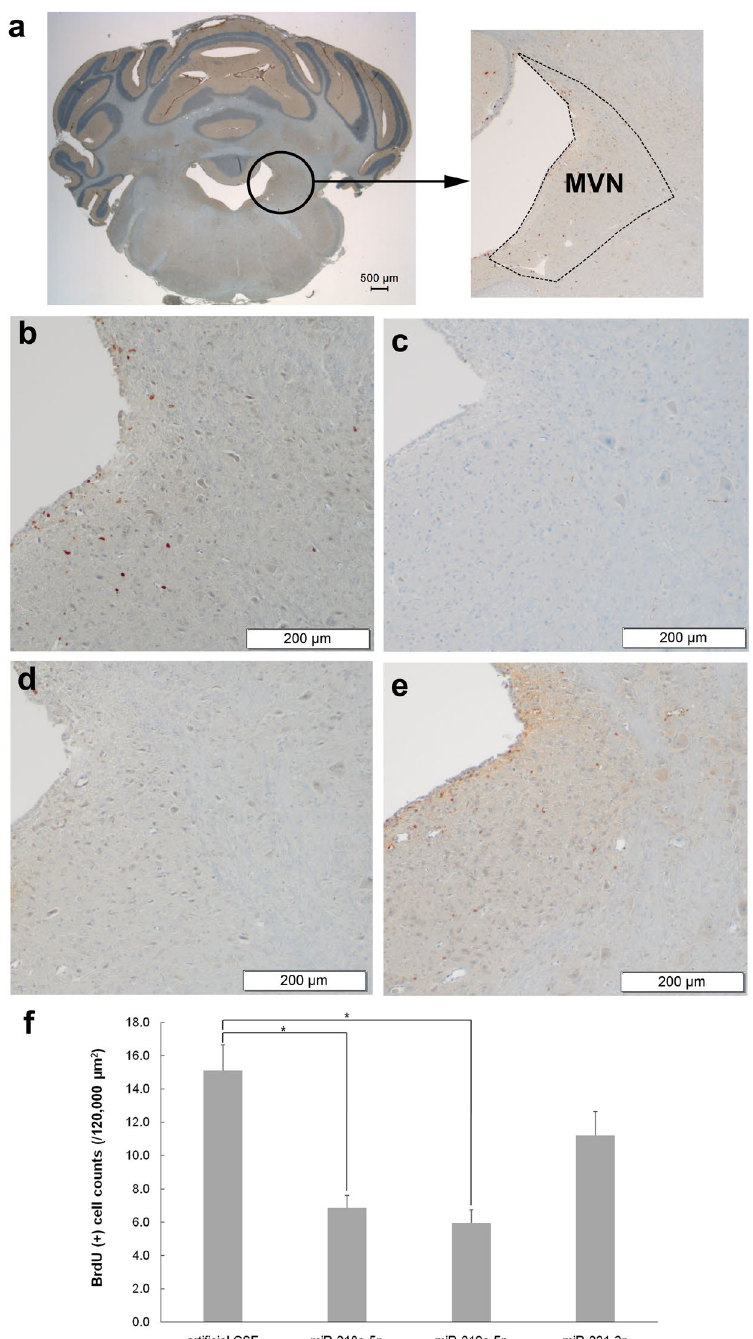
Figure 4. BrdU immunohistochemistry following administration of candidate miRNA oligomers. Twelve SD rats were divided into four groups. Artificial cerebrospinal fluid, miR-218a-5p antagomir, miR-219a-5p antagomir, or miR-221-3p agomir were administered into the intracerebroventricular space continuously for 1 week using the brain infusion cannula. All animals underwent unilateral labyrinthectomy 10 h following implantation of the brain infusion cannula. ( a ) MVN in the rat brain (Bregma − 11.60 mm). In the animals in which artificial cerebrospinal fluid ( b ) was administered, many BrdU-positive cells were observed in the MVN. However, in the animals in which miR-218a-5p ( c ) and miR-219a-5p 5p ( d ) antagomirs were administered, very few BrdU-positive cells were observed. In the animals in which the miRNA-221-3p agomir ( e ) was administered, several BrdU-positive cells were observed in the MVN. ( f ) The mean of BrdU-positive cell counts (/120,000 μ m 2 ) in the MVN from each group was analyzed. BrdU-positive cell counts were significantly lower in the animals in which the miR-218a-5p (mean difference = 8.2, p < 0.001) and miR-219a-5p 5p (mean difference = 9.1, p < 0.001) antagomirs were administered compared with the control group. * p < 0.001 (one- way analysis of variance with the Bonferroni correction). The error bars indicate standard error. SD, Sprague– Dawle; MVN, medial vestibular nucleus; BrdU, 5-Bromo-2 ′